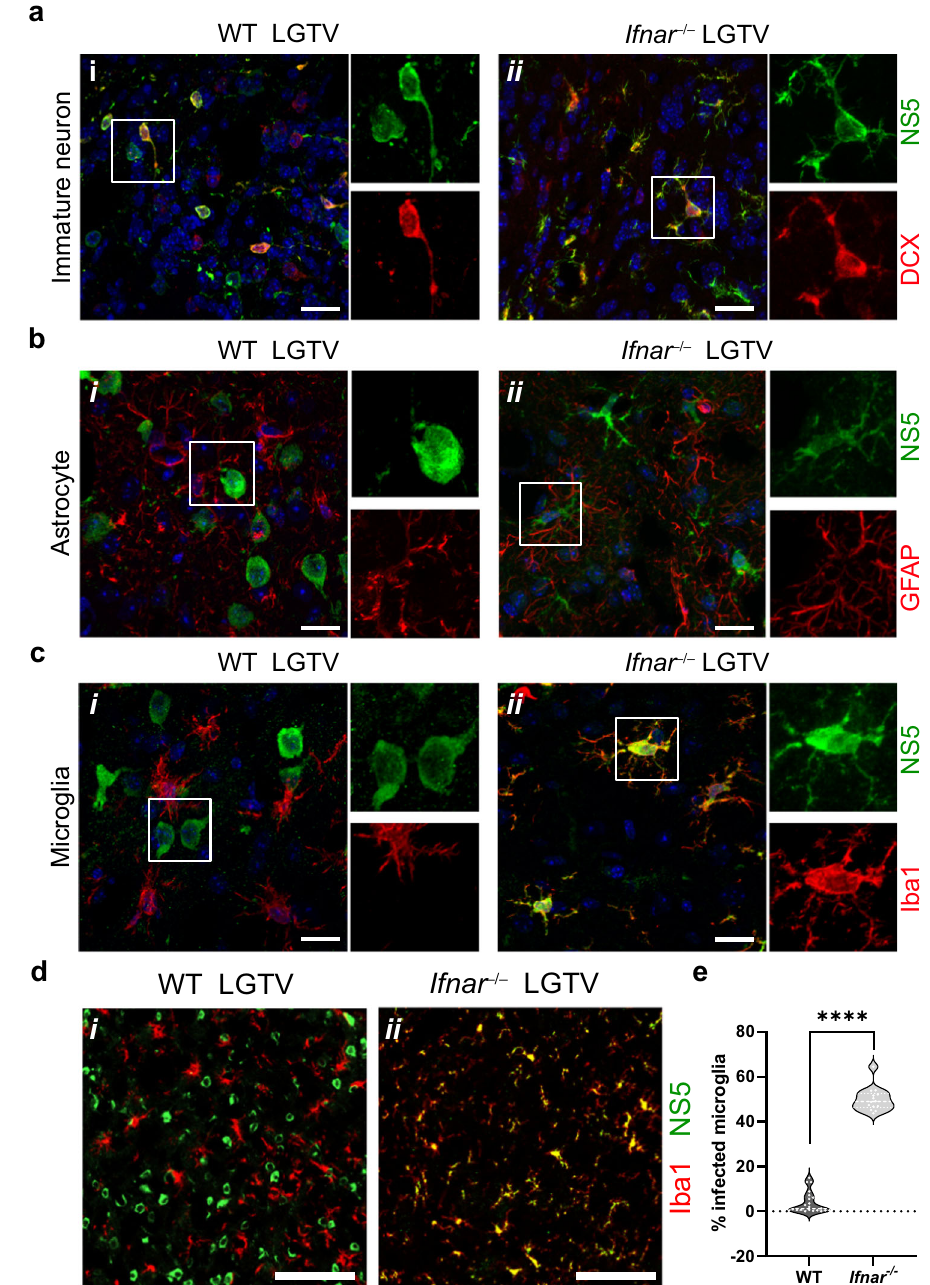
Fig. 4 | Lack of IFNAR expression shifts cellular tropism from neurons to microglia in the cortex of mice. a – c Maximum-intensity projection of confocal z-stack.Theimagesweretakenfromsagittalbrainsections(10 µ m)usingconfocal microscope ( n =3 per genotype). Scale bars = 20 µ m. a Captured at the granule cell layer of olfactory bulb. The sections were immunolabeled using anti-NS5 (green),anti-DCX (red) forimmature neurons in the rostral migratory stream and DAPI for nucleus (blue). b Captured within entorhinal cortex and piriform area. The sections were immunolabeled with anti-NS5 (green), anti-GFAP (red) for astrocyte and DAPI for nucleus (blue). c Captured within entorhinal cortex and